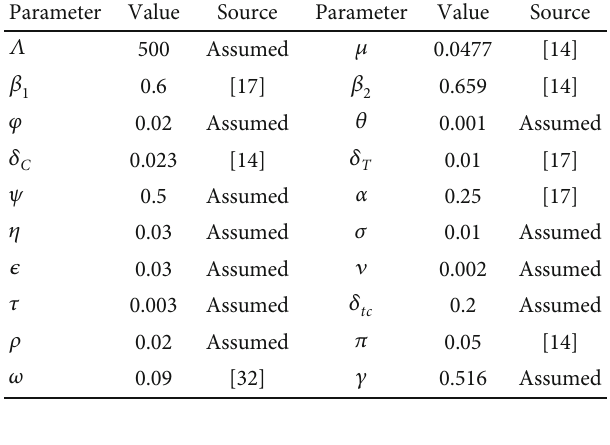
Table 3: The parameter values of the model equation (2) for our numerical solution.